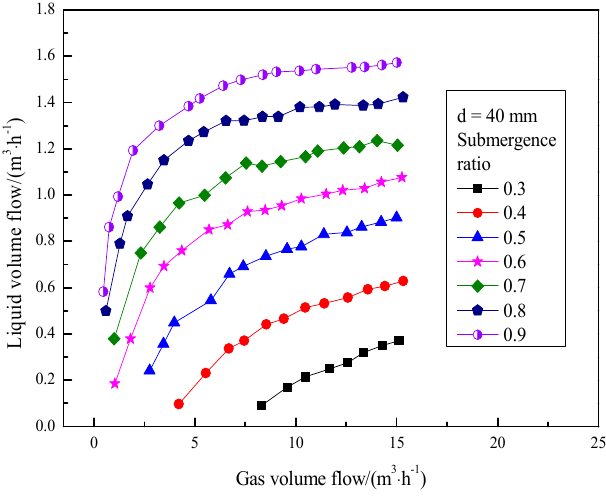
Figure 2. Changes of liquid flow with gas flow using 8 mm-wide circular holes.